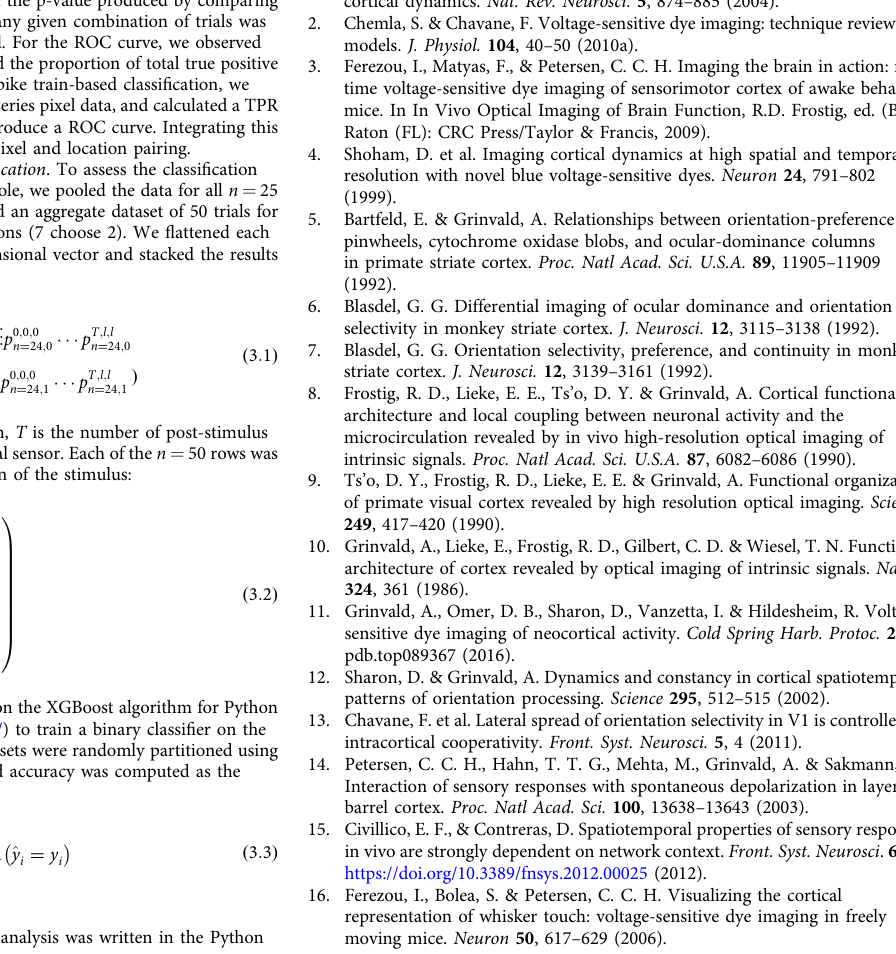
volumetric datasets, are available upon request. Source data are provided with this